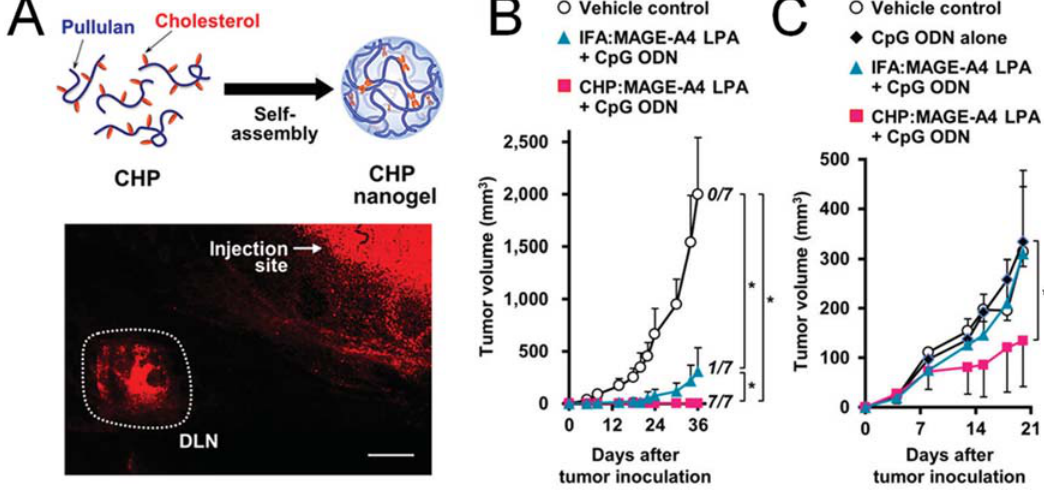
Figure 2. Anti-tumor efficacy improved by efficient lymphoid draining and retention of nanoparticle-based cancer vaccines. ( A ) Lymphoid draining of a fluorophore-labeled pullulan nanogel 6 h post subcutaneous injection to mice. Scale bar, 1 mm. The nanogel loaded with a long peptide antigen (LPA) MAGE-A4 achieved better prophylactic ( B ) and therapeutic ( C ) efficacy compared to the soluble antigen; ( B ) Mice were immunized on day -7, followed by inoculation of tumor on day 0; ( C ) mice were inoculated with tumor on day 0, followed by immunization on day 4 and 11. Reproduced with permission